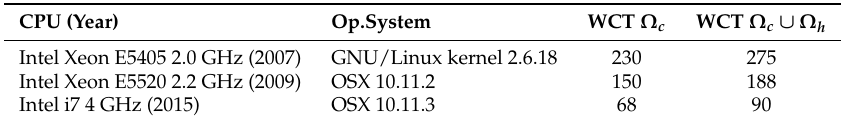
Table 1. Average Wall Clock Time (WTC) in seconds for a complete simulation with and without the evaluation of the acoustic field in Ω h